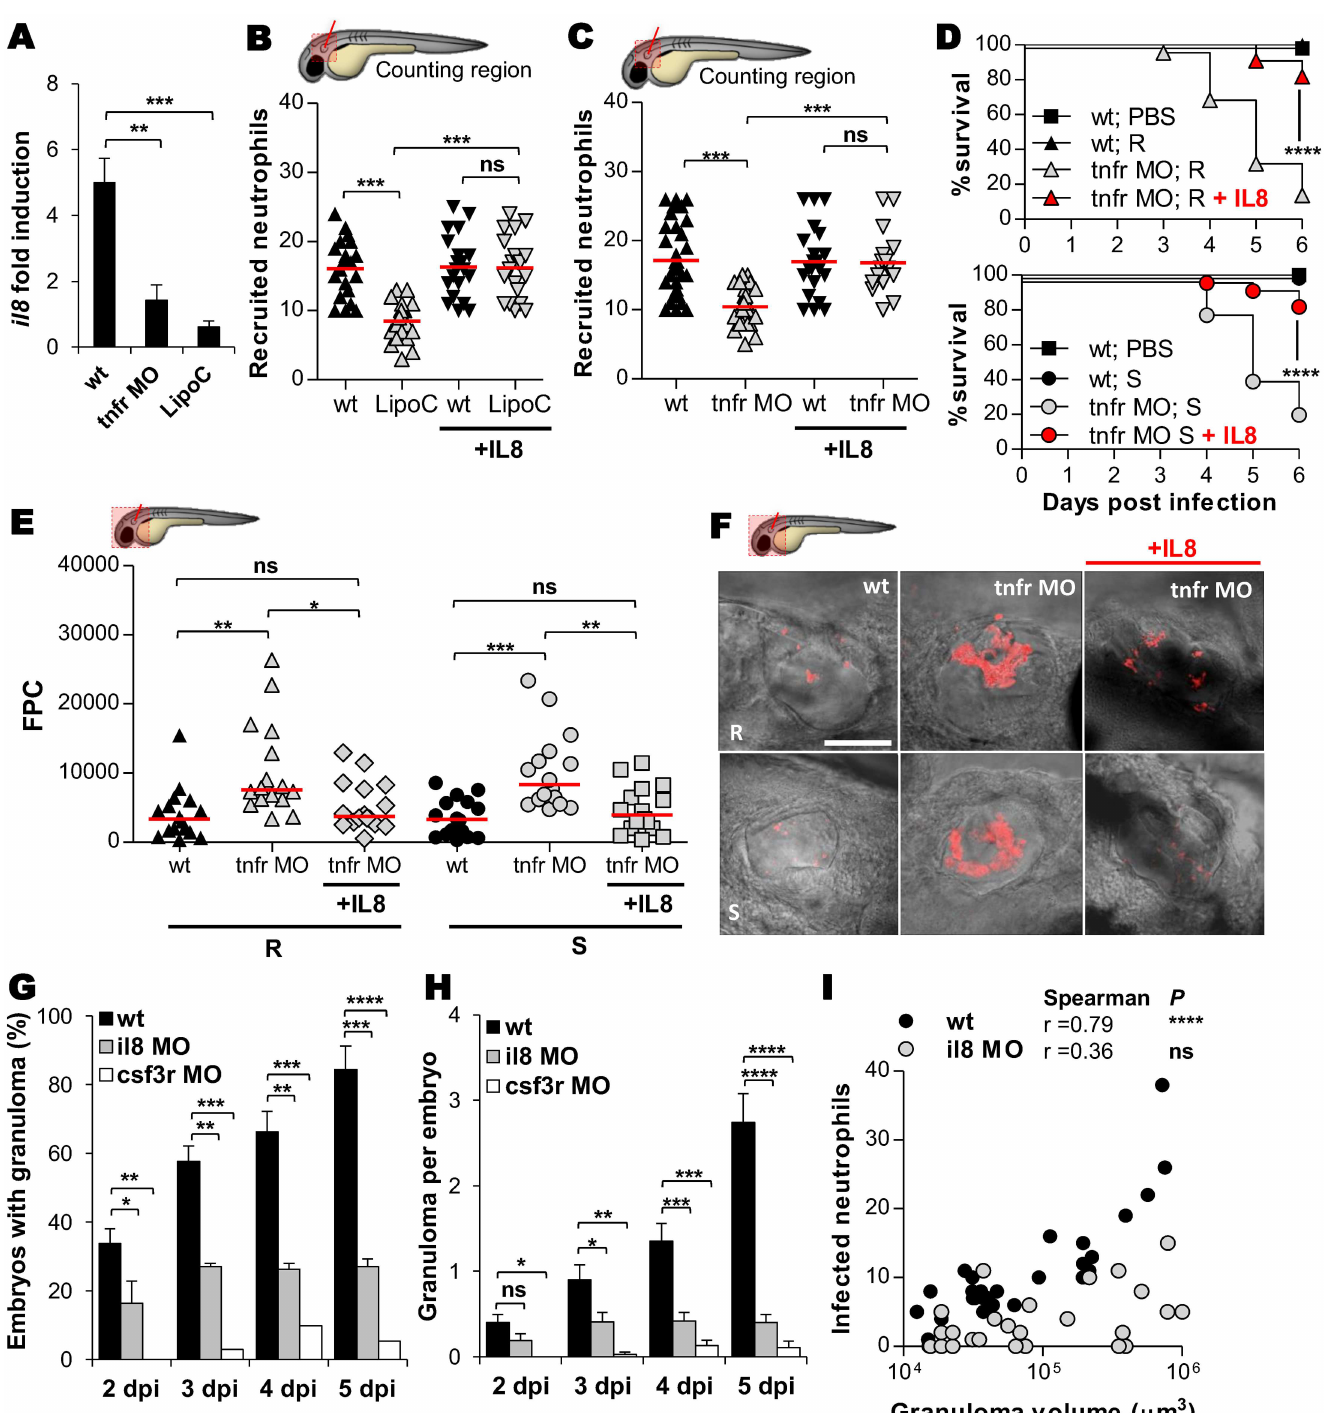
Fig 8. IL8-dependent mobilization of neutrophils is crucial for controlling M . abscessus infection and elaborating granulomas. (A) qRT-PCR of il8 (normalized to ef1 α ) upon Mabs infection in R Mabs iv infected WT, tnfr morphants or LipoC embryos ( (cid:25) 150 CFU). Fold inductionto PBS- injected animals at 3 dpi. Data are mean ± SEM of two independent experiments. (B and C) WT, LipoC embryos (B) or tnfr morphants (C) Tg(mpx : eGFP) embryos were infected into the otic vesicle with (cid:25) 150 R Mabs and treated with IL8 injection.Mean number of recruited neutrophils into the otic cavity in response to Mabs /IL8 injectionat 3 hpi. Each symbol represents individualembryos and horizontallines indicate the mean values. (D-F) WT or tnfr morphants were injected into the otic cavity with either (cid:25) 150 R or S variants expressing tdTomato and treated with IL8 injection.(D) Survival of R-(up) or